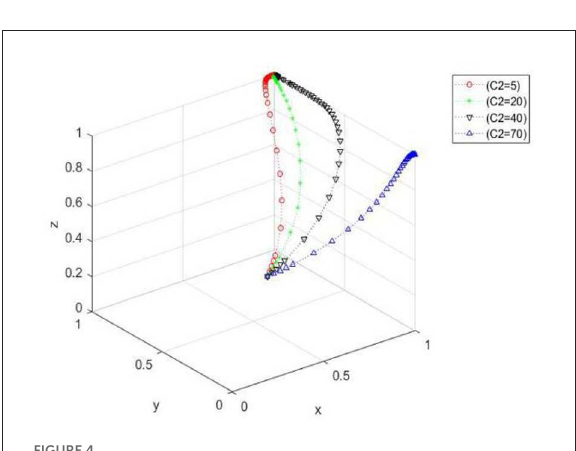
FIGURE4 Spatial diagram of the influence of the change of production safety cost on the evolution path of peasant households managed by cooperatives.